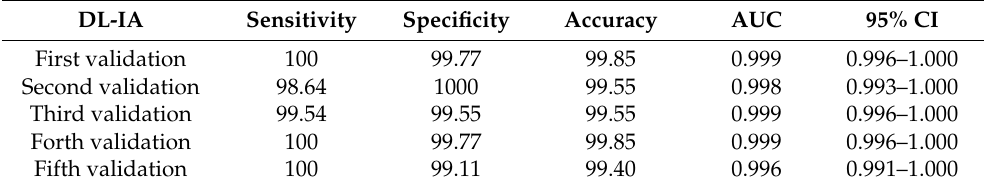
Figure 4. Receiver operating characteristic analyses with area under the curve (AUC) for DL-IA ( A ), DL-OA ( B ), DL-IB ( C ), and DL-OB ( D ) models. Table 1. Results summary of five-fold, cross-validation of DL-IA model for detecting incomplete scan coverage at the lung apex (CI, confidence interval).